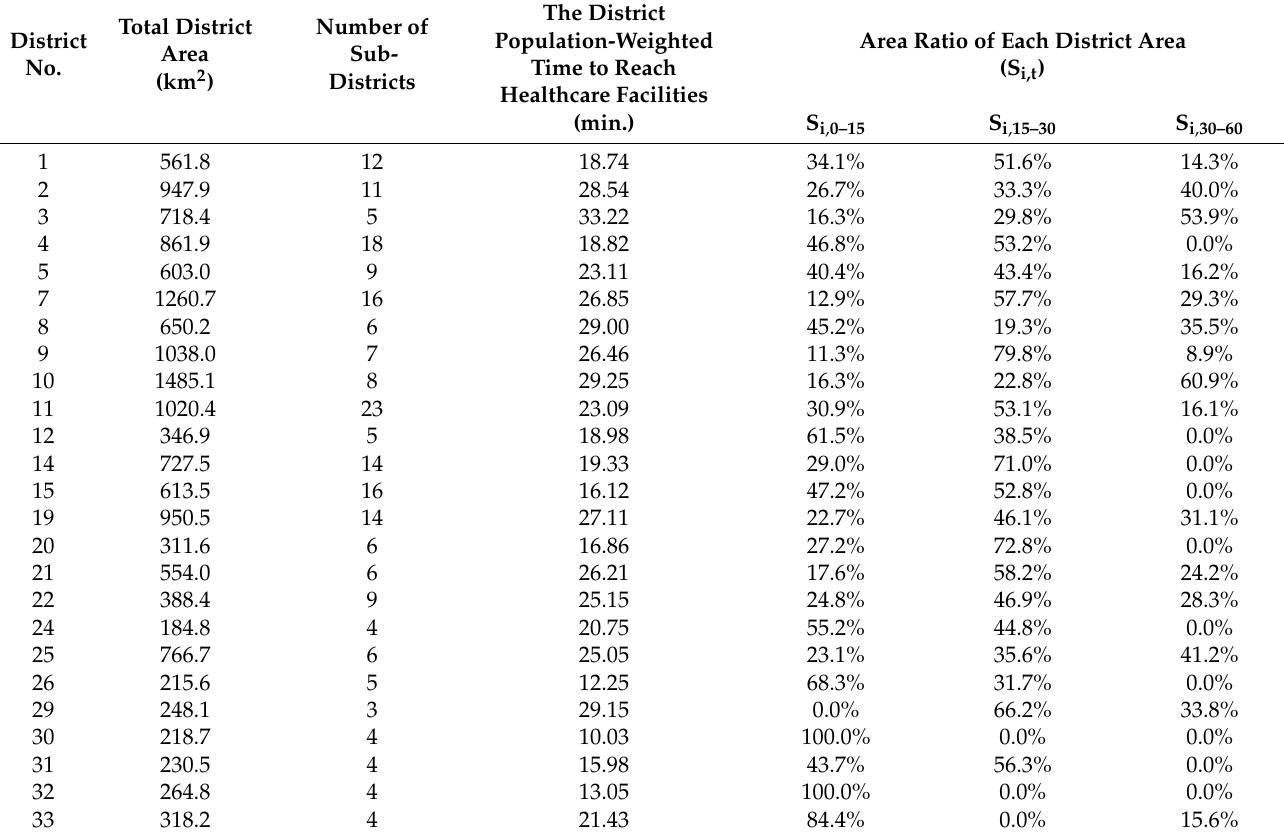
Table 4. Summary of accessibility of areas for each district based on the travel duration to healthcare